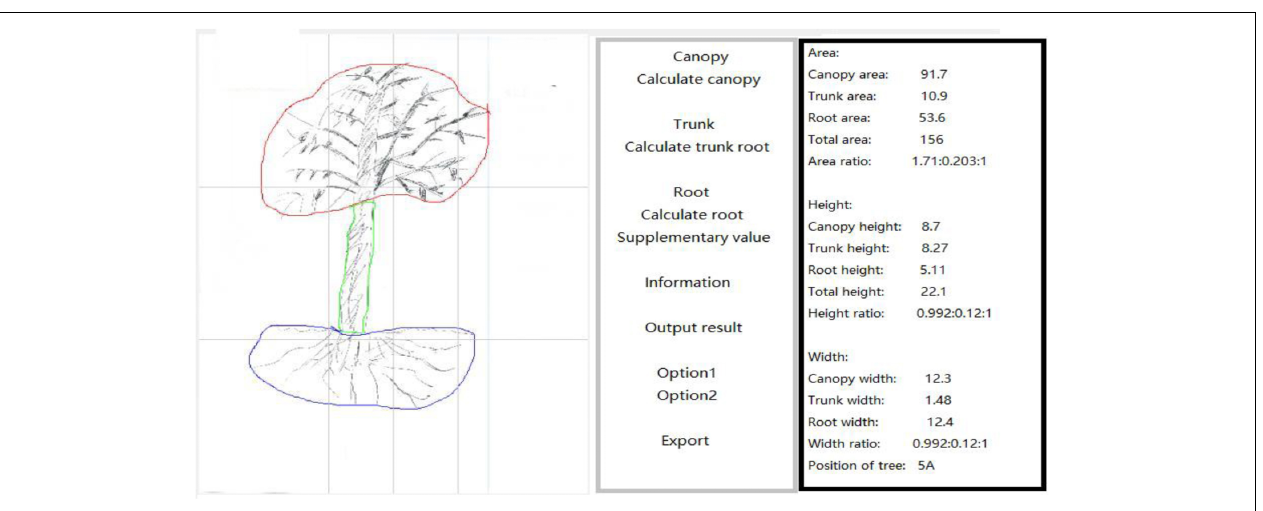
FIGURE 3 | Example of scanned tree in control